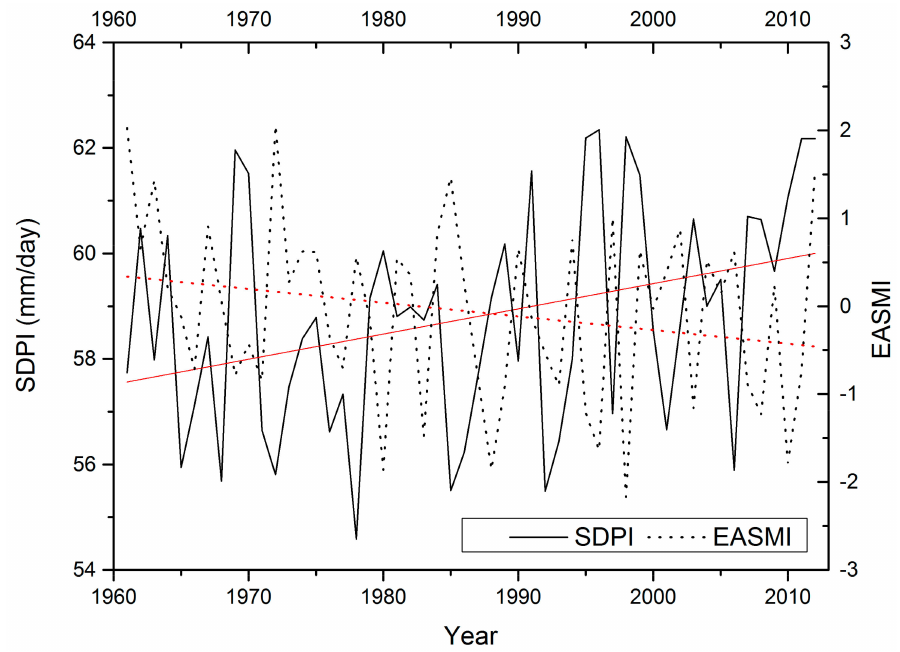
Figure 8. Interannual variations of SDPI and EASMI in the MLR-YR from 1961 to